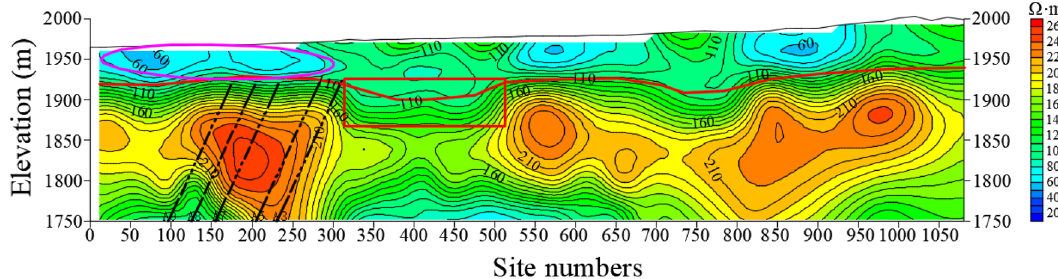
Figure 11. The resistivity profile of the TEM of L34.